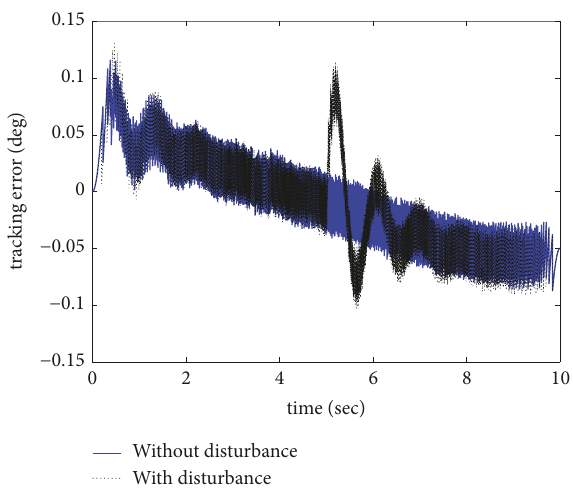
Figure 9: Two tracking error curves of third-order